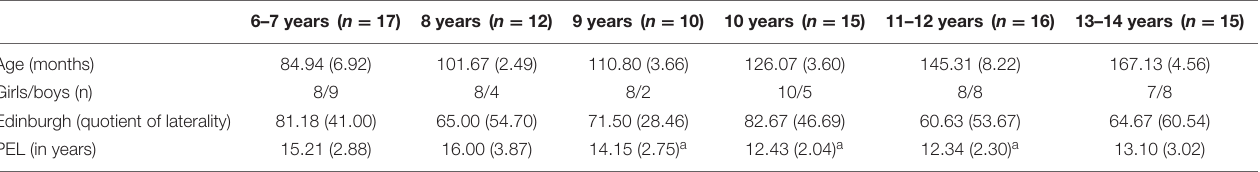
TABLE 2 | General data related to the different age groups of the sample.